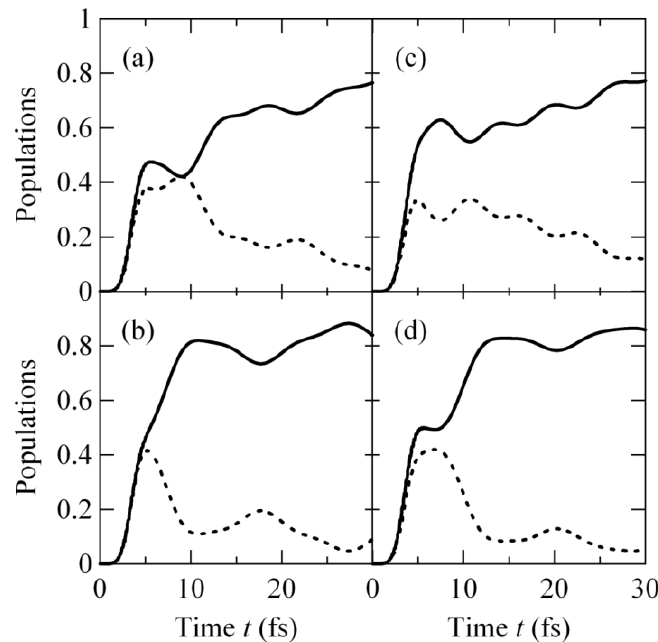
Figure 4. Temporal behavior in the populations of the quasi-degenerate excited states for ( a ) e (+) , ( b ) e ( − ) , ( c ) e +1 , and ( d ) e − 1 calculated from nuclear WP simulations. In each panel, the populations of X and Y are denoted by the solid and dotted lines, respectively. The laser pulses fully decay at t = 7.26 fs. Reprinted from [56] with permission of the American Chemical Society.